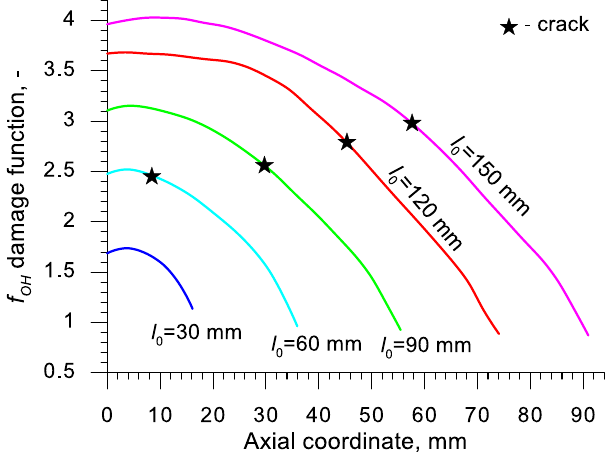
Figure 23. Distributions of the damage function in the axis of a rotationally compressed sample, determined on the basis of the Argon et al. criterion.